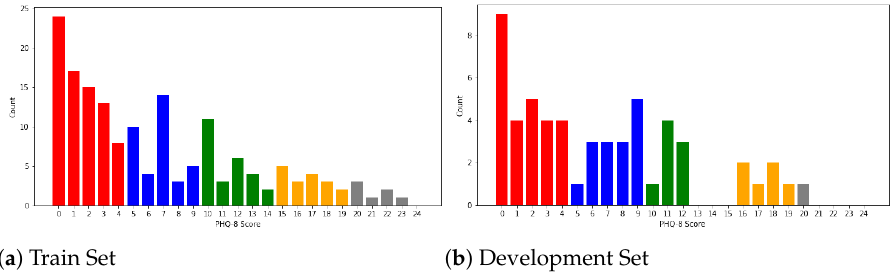
Figure 3. The distribution of the training and development set of the AVEC 2019 DDS Chal- lenge dataset.